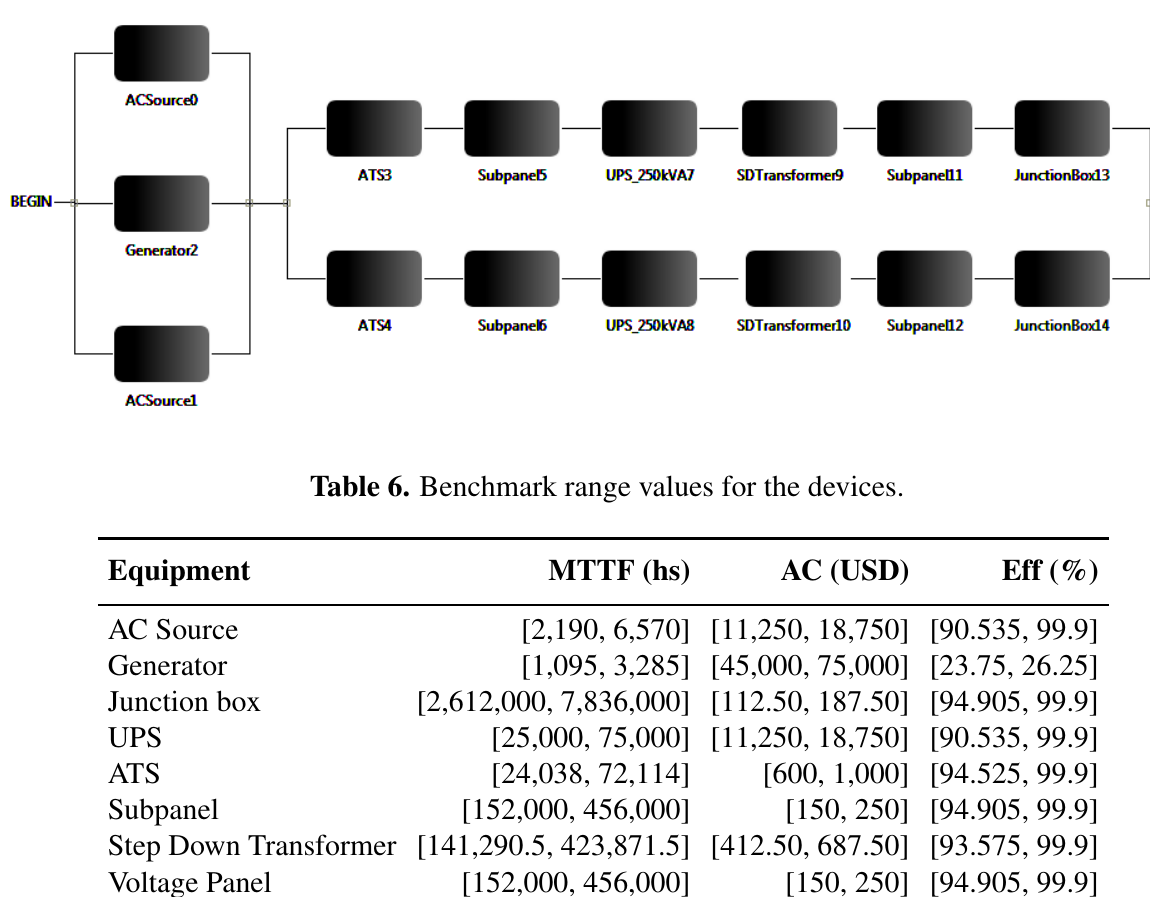
Figure 21. RBD for the power infrastructure.